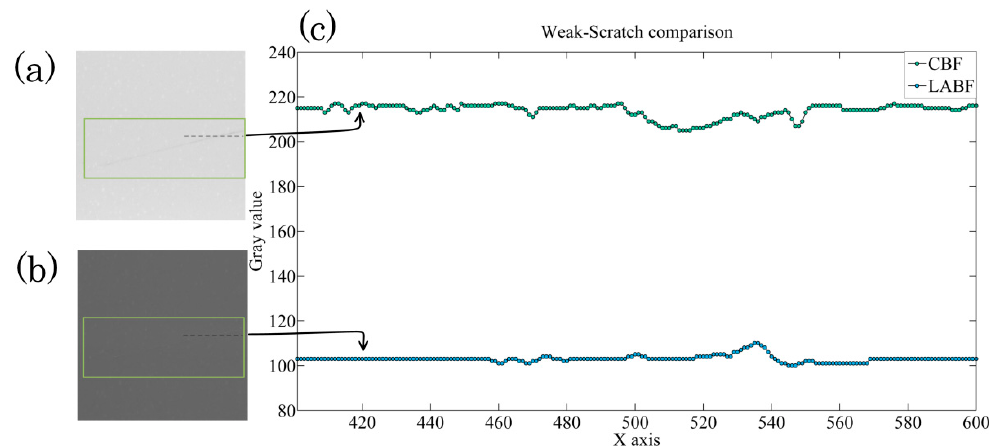
Figure 2. Grayscale distribution of the shallow scratch: ( a ) The image of the shallow scratch defect in the CBF system; ( b ) The image of the shallow scratch defect in the LABF system; ( c ) Grayscale distributions of the shallow scratch in the CBF system and LABF system.